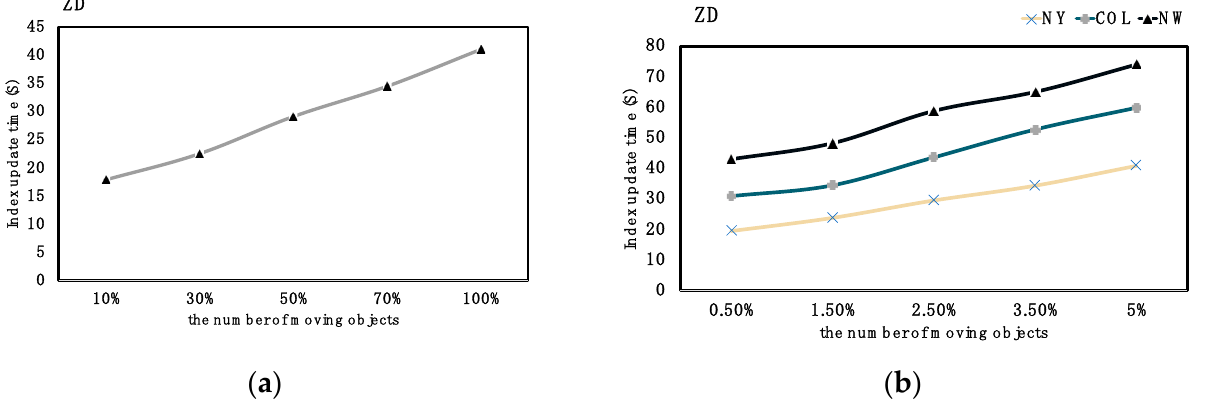
Figure 11. Time cost of updating DVTG-Index w.r.t. the number of moving objects. ( a ) Time cost on BJ; ( b ) Time cost on NY, COL and NW.